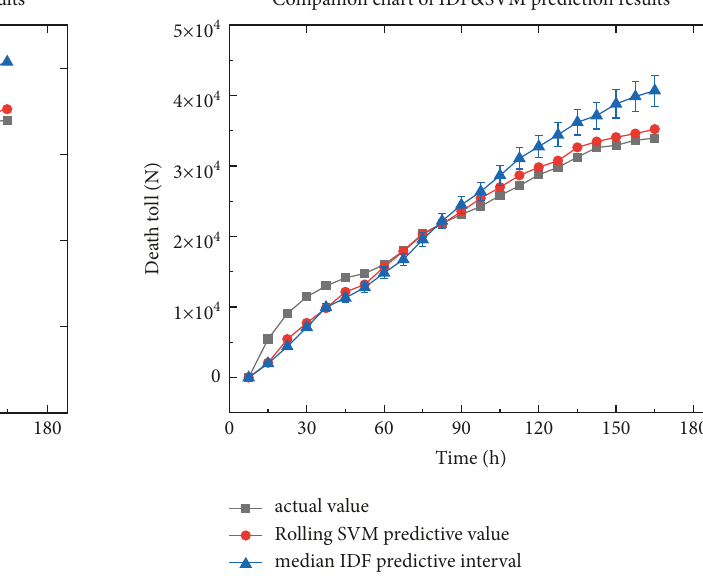
Figure 10: Comparison between rolling and static predictions. Figure 11: Variation trend of prediction results of IDF